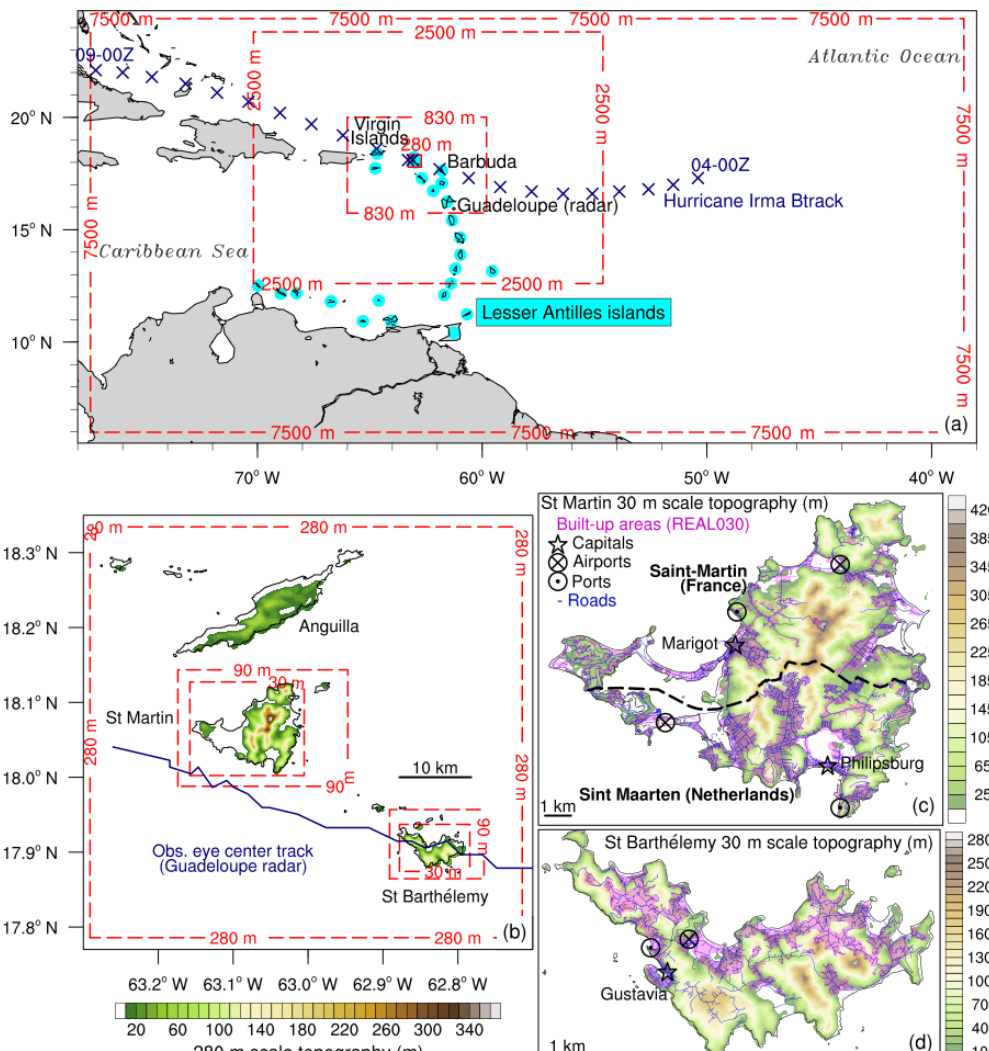
Figure 2. Nested domains map: (a) from 7.5km scale to 280m scale and (b) from 280m scale to 30m scale. Terrain height ( m ) : at 280m scale (b) and at 30m scale for St Martin island (c) and St Barthélemy island (d)